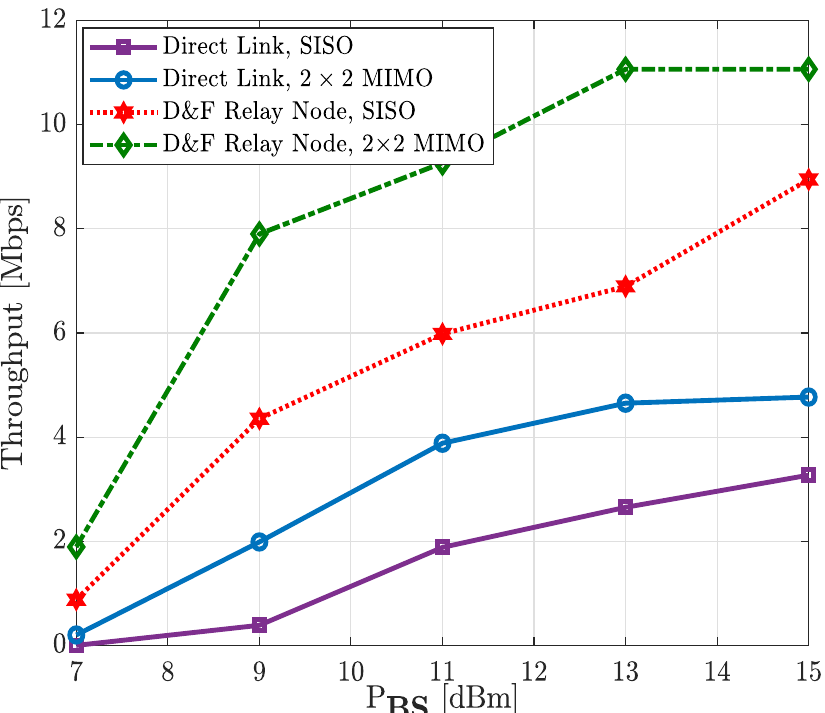
Figure 19. Throughput vs. P BS of the relay node co-operative 5G network;